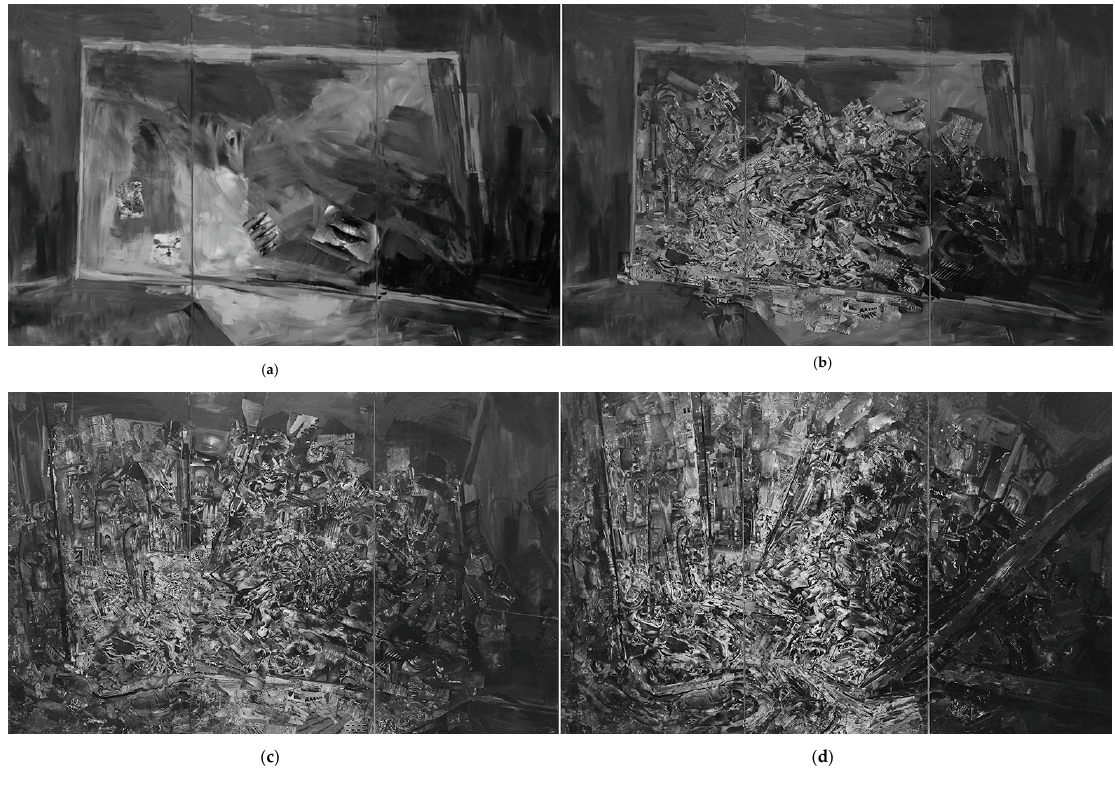
Figure 6. Sabine Hertig, Untitled 2012, Analogue Collage on Paper 27 × 20 ccm, Archive No. 0062. The processes of her more recent, large-scale landscape series are beginning with a painted ground in which a spatial situation is indicated through loose brush strokes in various shades of grey (Figure 7a). Landscape 14, developed from February until September 2017, began by painting a spatial description connecting the three separate vertical panels. Within the rectangular shape of the canvas, a smaller horizontal rectangle is established with a lighter grey, indicating a stage-like situation. A plane leads from the bottom of the canvas to the